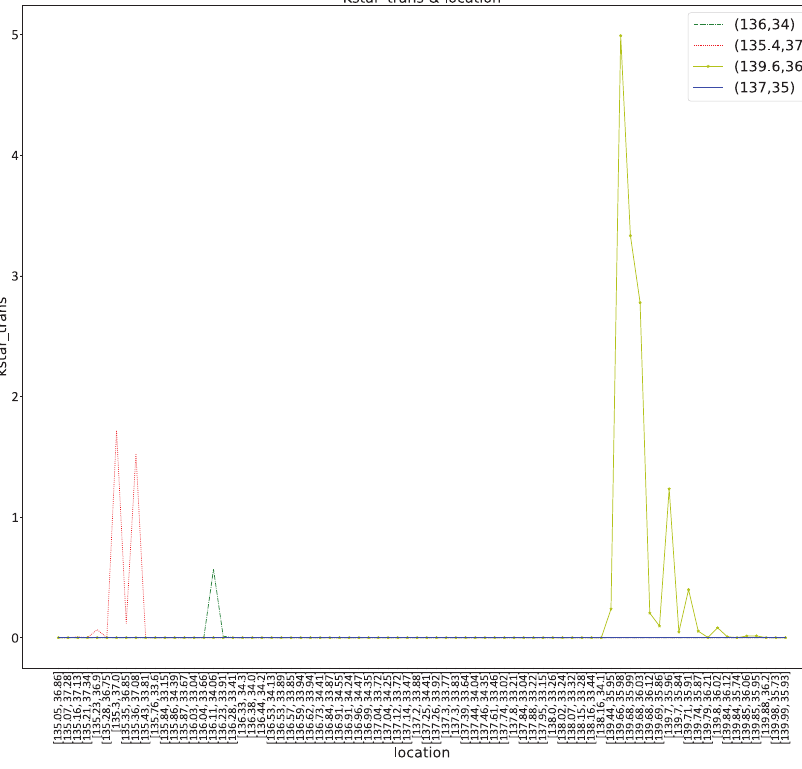
Figure 5. The relationship between distance and covariance. The blue line represents a location where no event has occurred (137 ◦ E, 35 ◦ N), the red line, green line, and yellow line represent three locations near to the historical events, in order (136 ◦ E, 34 ◦ N), (135.4 ◦ E, 37 ◦ N), (139.6 ◦ E, 36 ◦ N). It can be seen from the graph that covariance is related to whether an earthquake has occurred and its